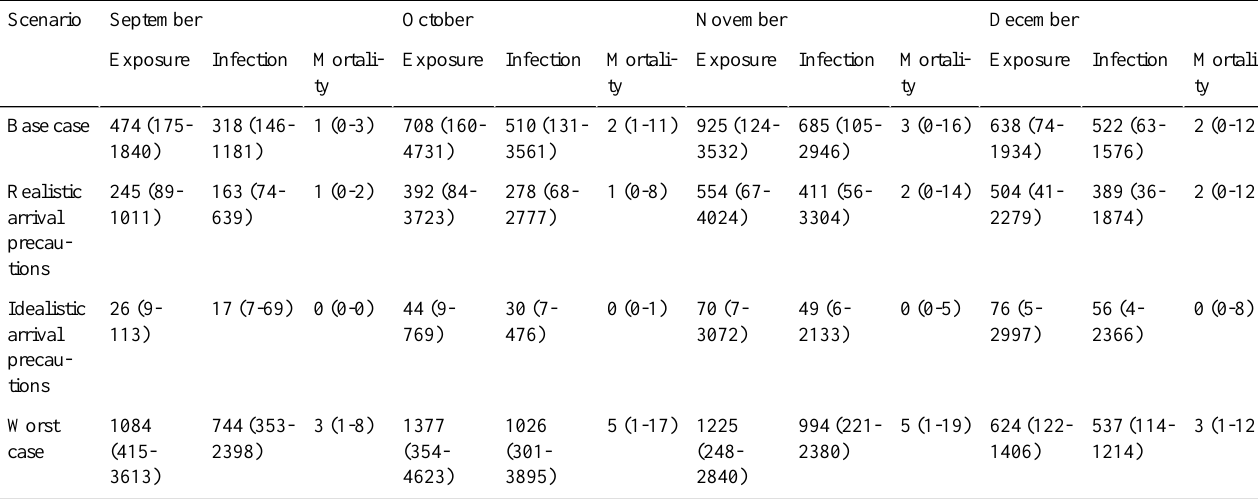
Table 3. Predicted median number of monthly COVID-19 exposures, infections, and deaths per 10,000 students during fall 2020 (northeast US urban university example). Values in parentheses indicate 95% probability